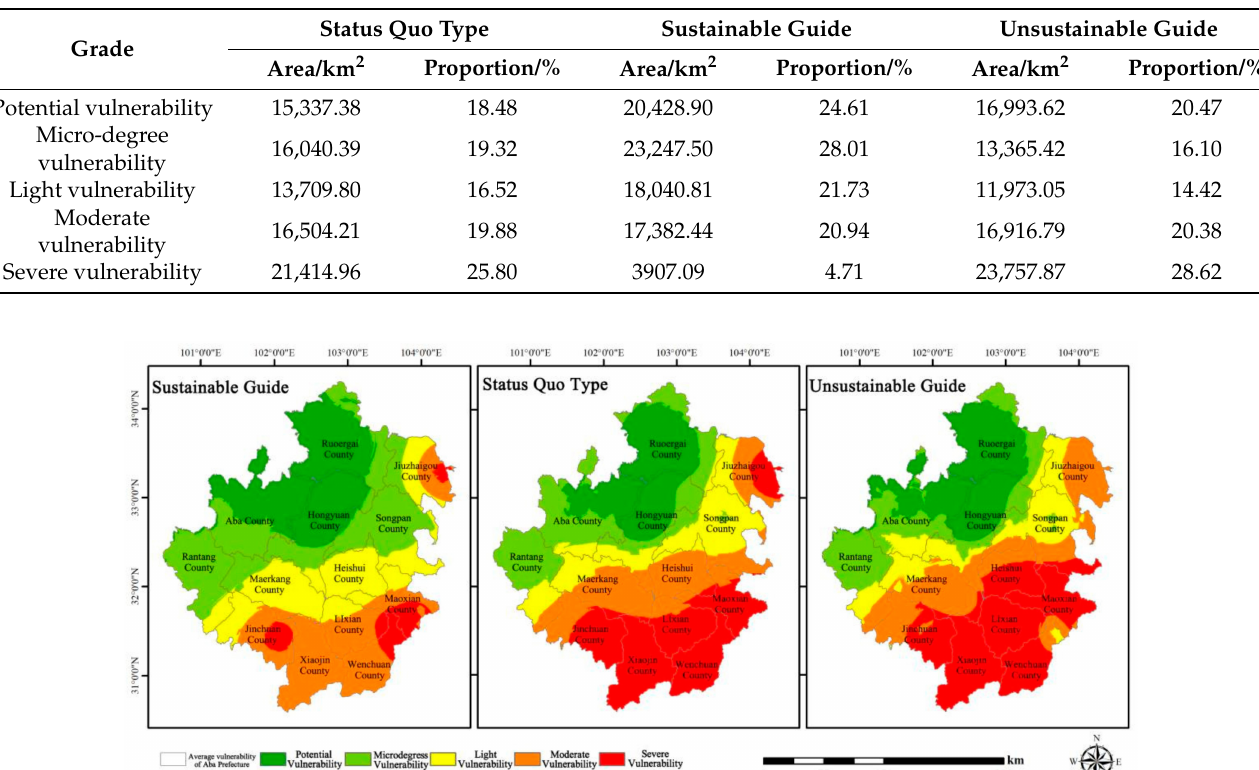
Table 12. Scenario simulation results of different socio-ecological vulnerability grades in Aba Prefecture, Western Sichuan Plateau.